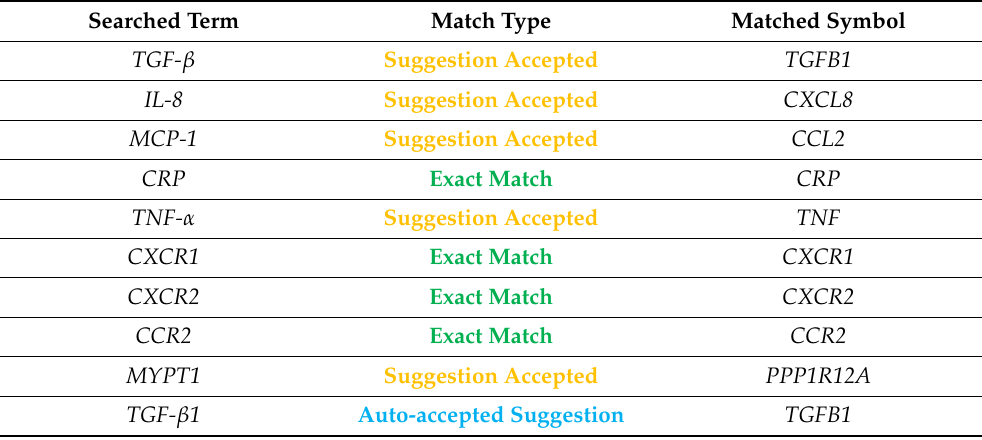
Table 1. Results of an example search of inflammation-related genes with GeneToList, demonstrating the disambiguation of gene IDs. Color corresponds to different match types where Green were exact matches between the searched term and the NCBI official symbol, Blue were auto-accepted suggestions where the searched term was similar to an official symbol and Orange were search terms which required alias disambiguation.